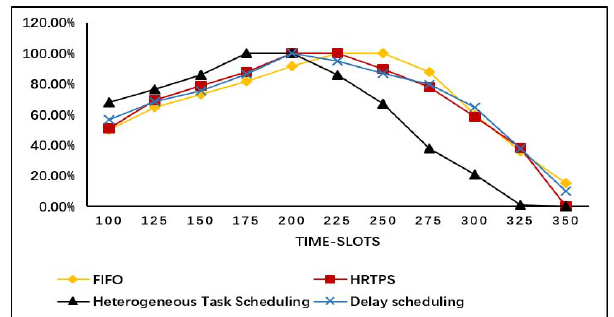
Figure 2. Experimental results of server utilization.